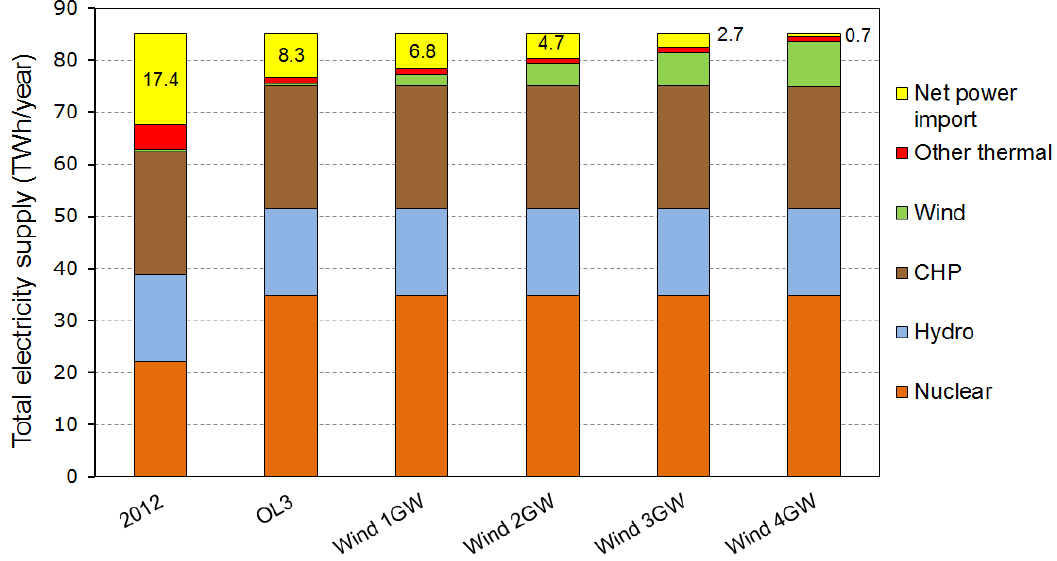
Figure 6. Evolution of power supply mix in Finland from 2012 to the commissioning of Olkiluoto 3 (OL3), and further in wind integrations up to 4000 MW (power demand 85 TWh/a)—The amount of net power imports are labeled on each bar.